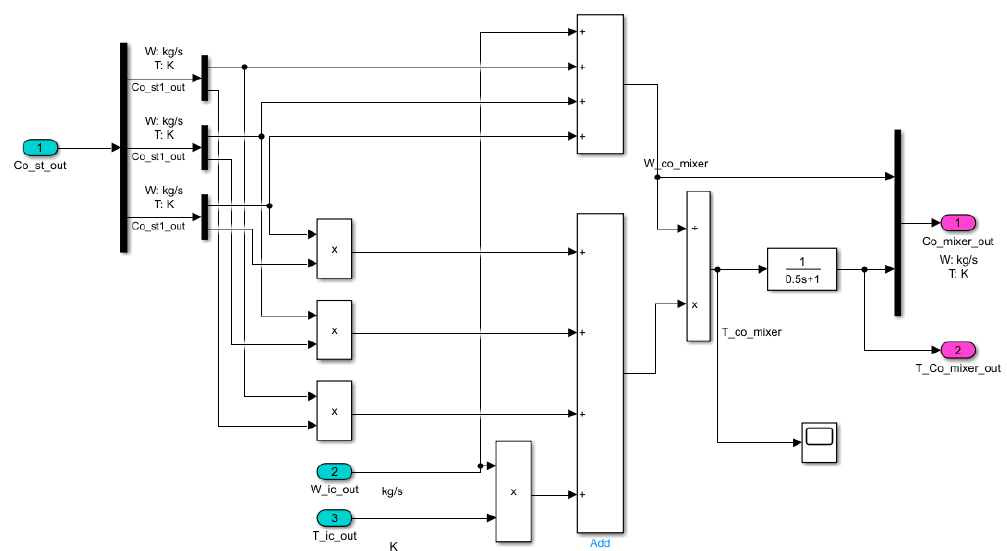
Figure 3. The Simulink model of the mixer.